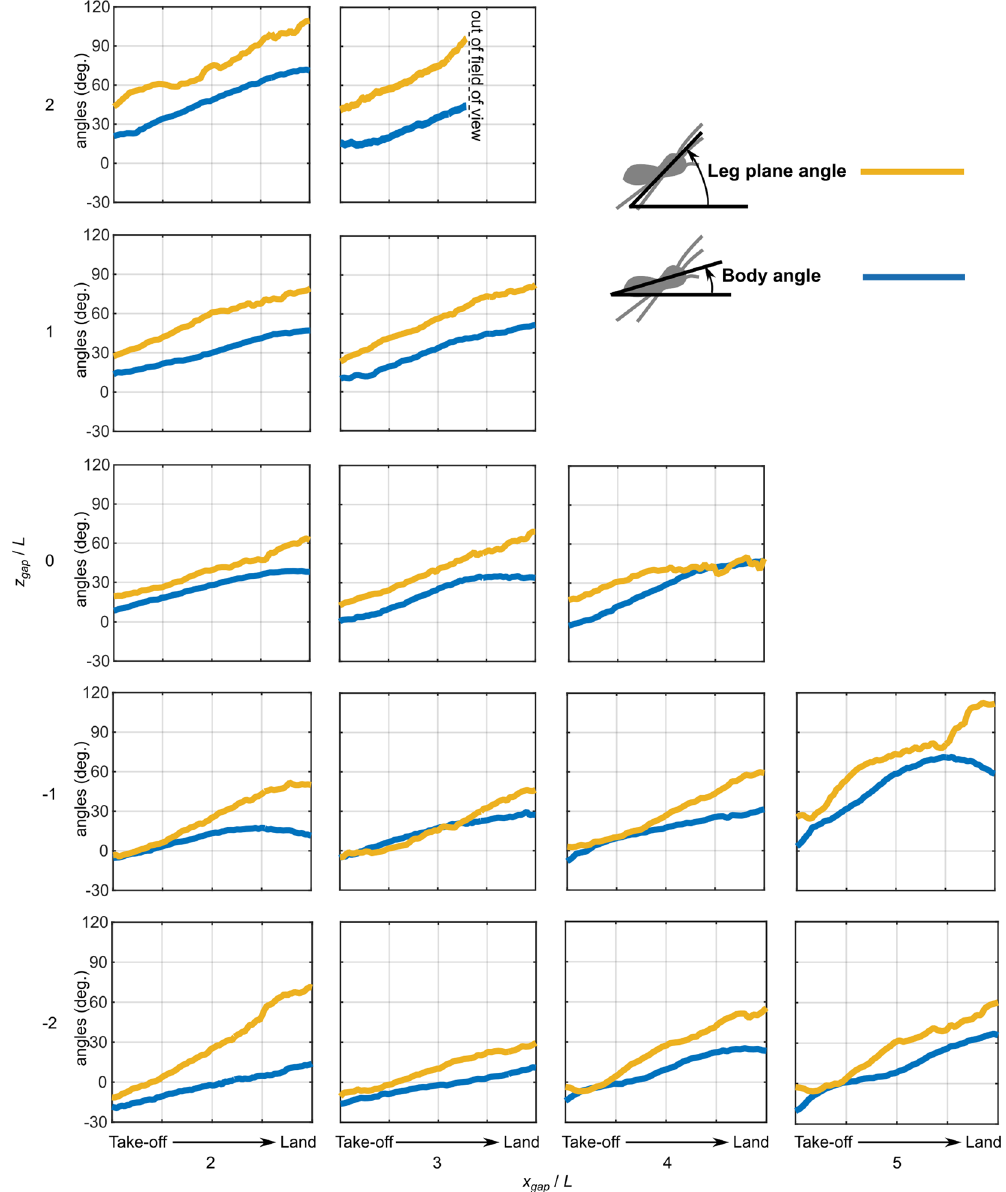
Figure 5. Variations of the body angle and leg plane angle from take-off to landing. Take-off and landing are as defined in Fig.